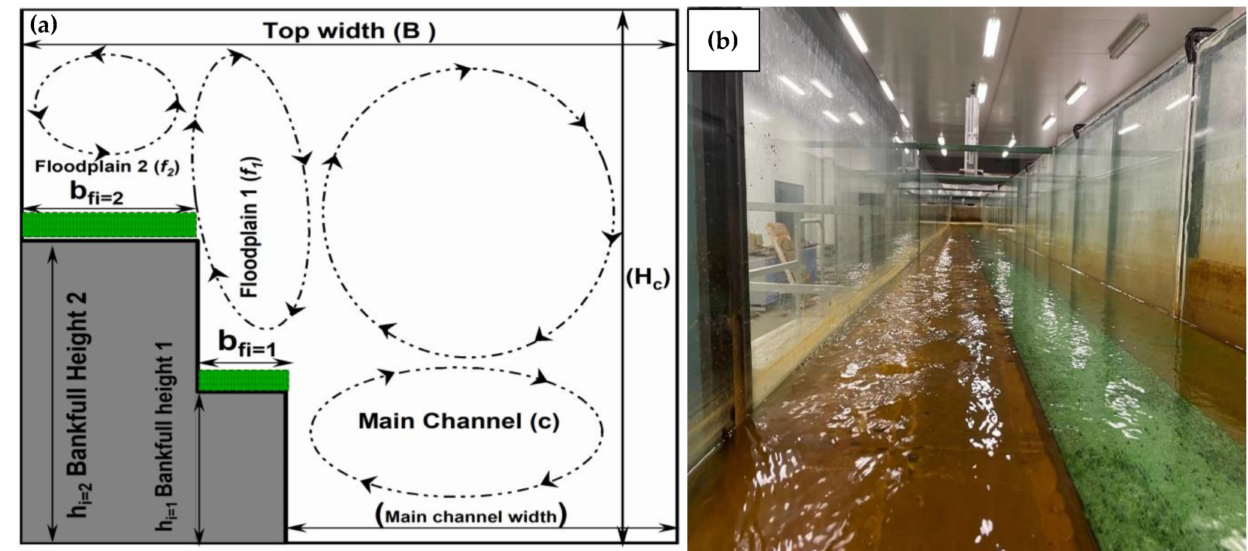
Figure 1. ( a ) Cross-sectional view of the staged floodplains and main channel of the experimental test case and ( b ) pictorial view from the downstream end of the compound channel with synthetic grass turf used for the floodplain. Note: H c denotes the flow depth in the main channel; B is the top width; c is the main channel width; h i and b fi are floodplains’ depth and bed width,